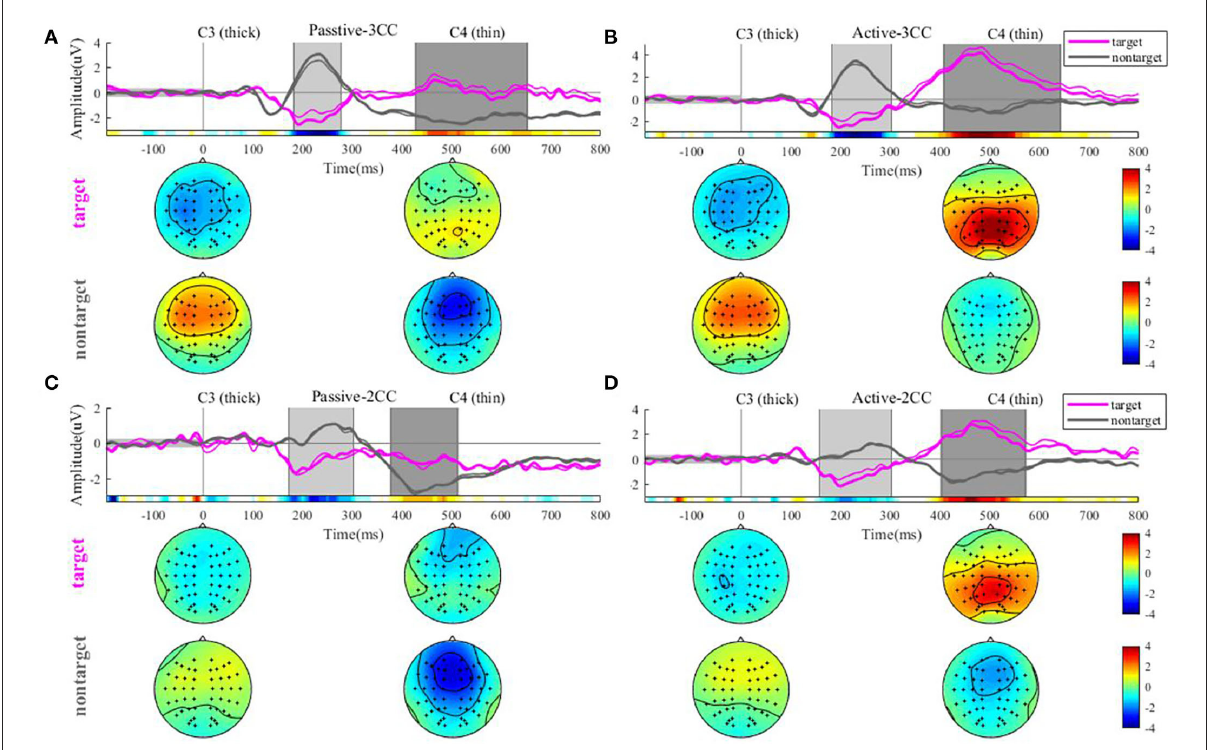
FIGURE3 Average ERP waveforms at C3 and C4 electrodes of 12 people under 4 conditions in sequence. In each subfigure, (A–D) the pink and gray colors denote target and non-target stimuli, and the thick and thin lines denote C3 and C4 channels, respectively. The gray rectangle represents the time intervals that have a significant difference, and the colored long rectangle under the lines represents the sign r 2 results for the entire time period. The circle below the waveform graph is the average amplitude topographic map in the first and second time intervals.